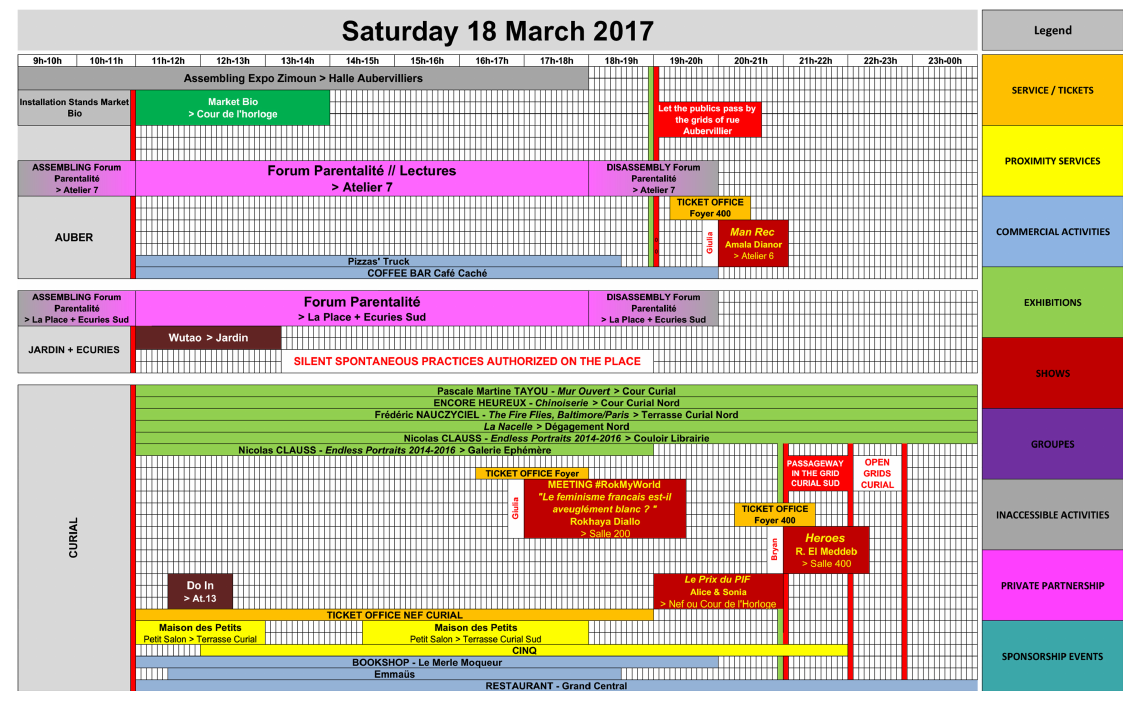
Figure 4. Planning sheet of Centquatre for 18 March 2017 c (cid:13) CENTQUATRE-PARIS.